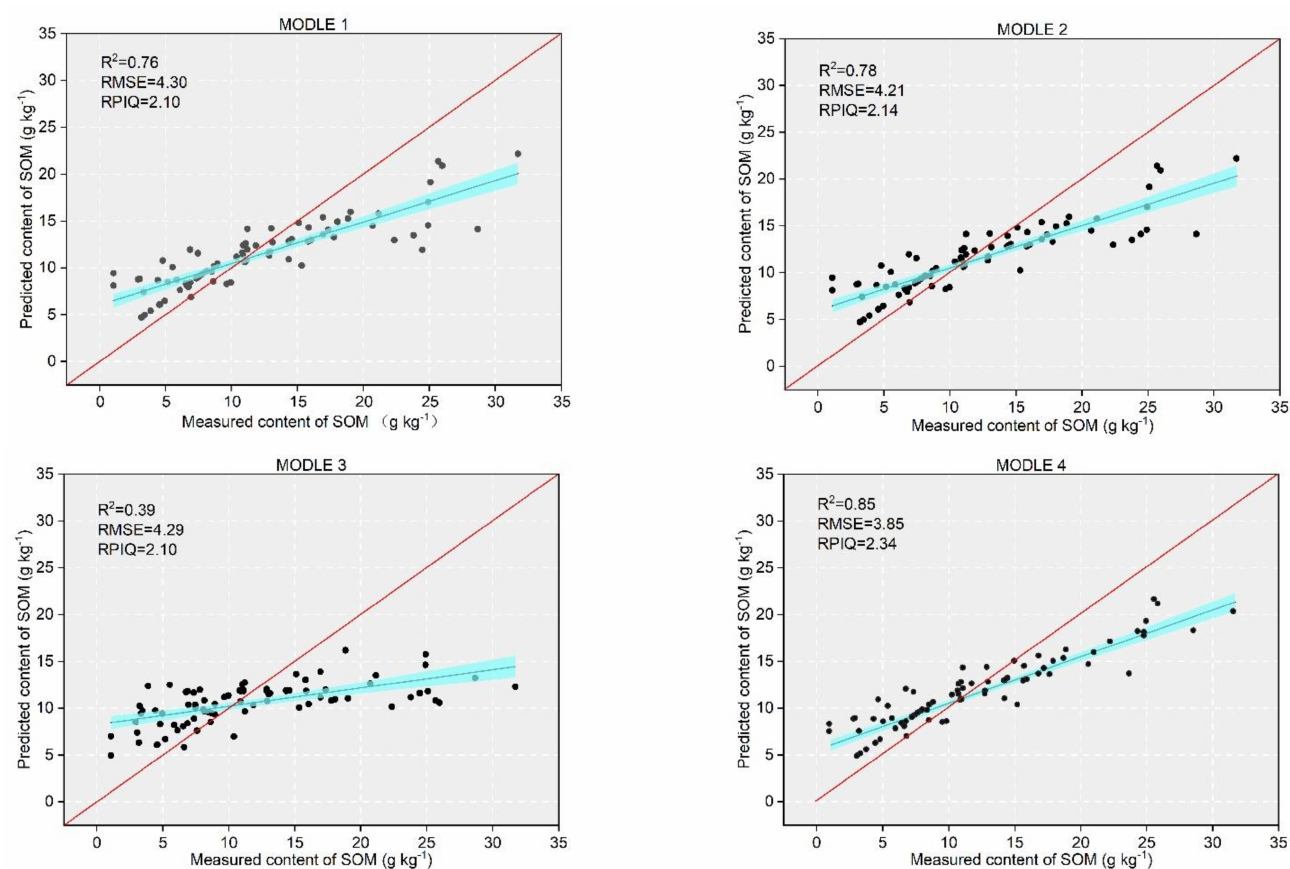
Figure 6. SOM models using the validation dataset (the blue area in the figure is the 95% confidence interval, the red line is the 1:1 line, and the black line is the fitted line) Model 1, SOM ~ hyperspectral; Model 2, SOM hyperspectral + spectral classification; Model 3, SOM ~ environmental variables; and Model 4, SOM ~ hyperspectral + spectral classification + environmental